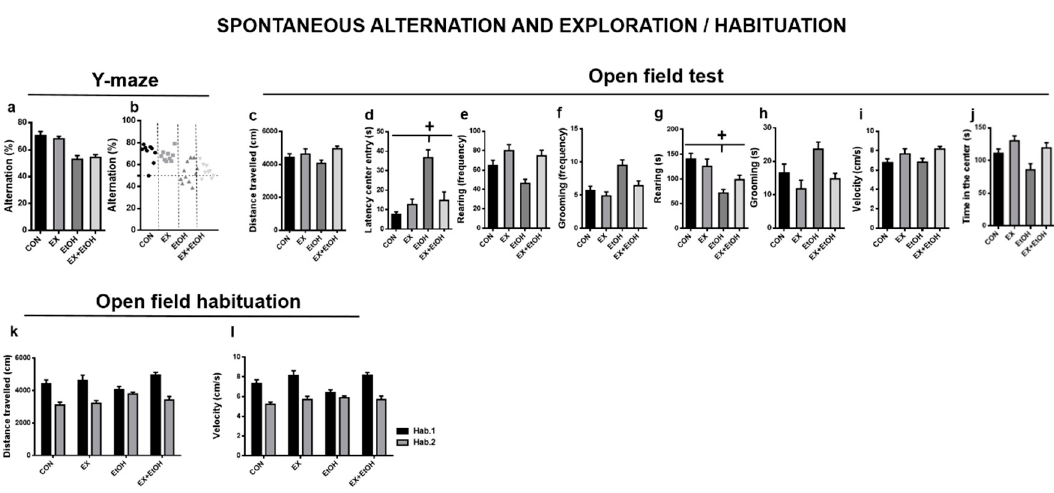
Figure 4. Behavioral performance in Spontaneous alternation and exploration / habituation. ( a , b : Y-maze; c – j : Open field (exploration); k , l : Open field (habituation). All data are mean ± SEM, and statistically significant di ff erences were considered when p < 0.05. + Represents statistical di ff erences between the EtOH condition compared to other groups.